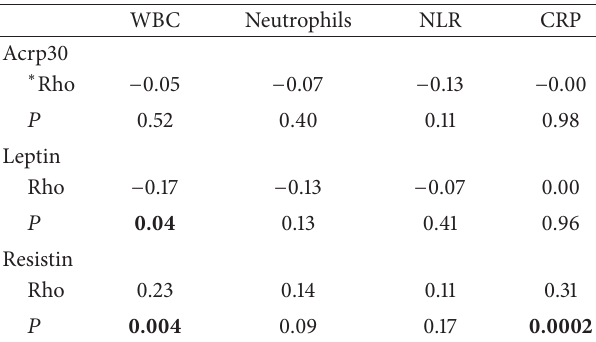
Table 9: Analysis of a correlation between serum adipokine levels and traditional markers of